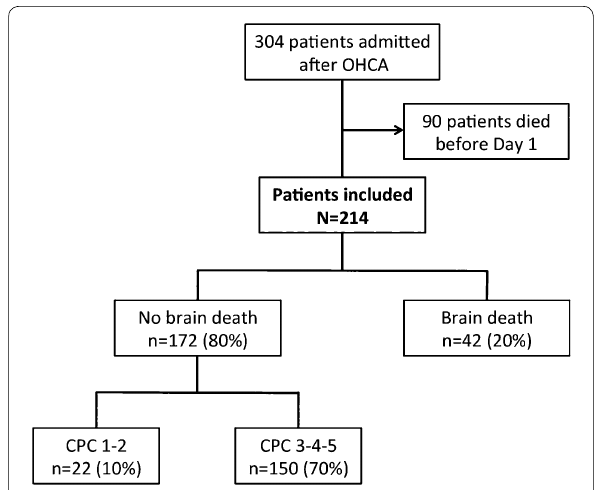
Fig. 1 Flowchart. OHCA out-of-hospital cardiac arrest, CPC Cerebral Performance Categories